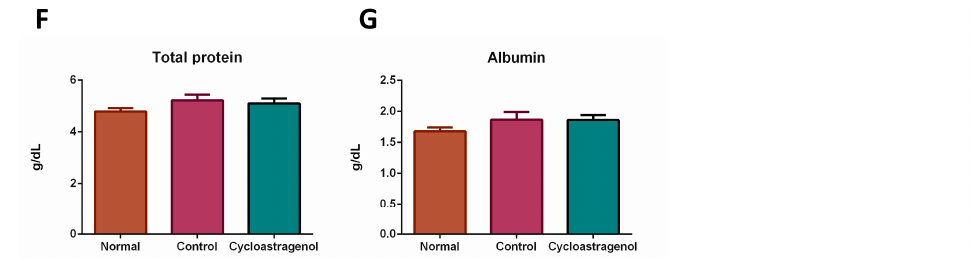
Figure 5. Hepatoprotective efficacy of cycloastragenol (200 mg/kg) on the levels of markers associated with liver toxicity in the serum of mice treated with carbon-tetrachloride. Levels of alanine aminotransferase ( A ), aspartate aminotransferase ( B ), alkaline phosphatase ( C ), total bilirubin ( D ), direct bilirubin ( E ), total protein ( F ), and albumin ( G ) are shown. Bar graphs and corresponding error bars indicate means and SEM among the same treatment, respectively ( n = 8–10). a , aa , and aaa indicate p < 0.05, 0.01, and 0.001 when compared with the normal, respectively. bbb indicates p < 0.001 when compared with the control.